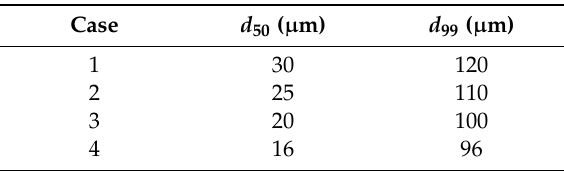
Table 5. Separator e ffi ciency.